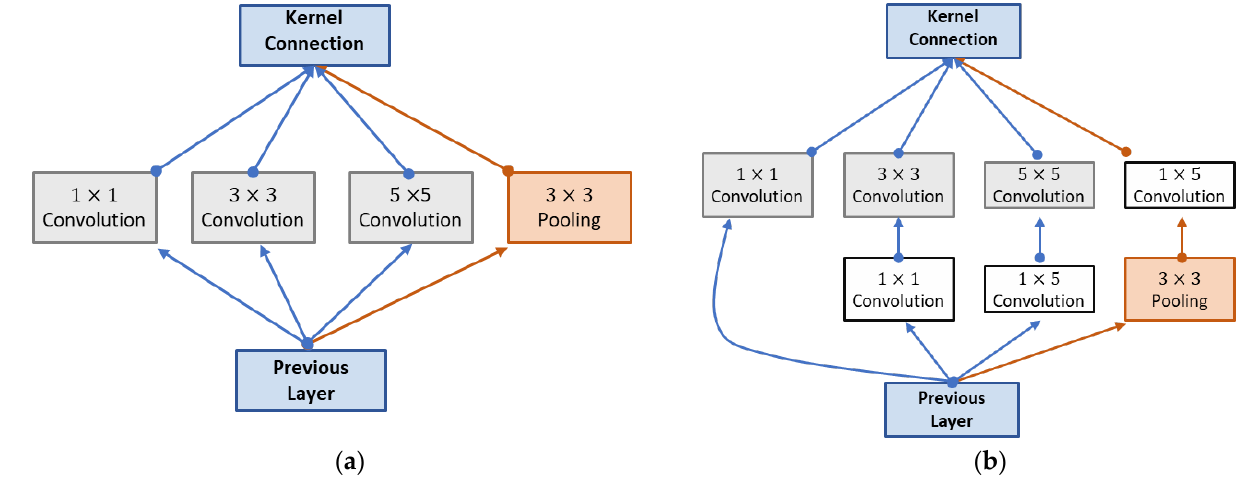
Figure 4. GoogleNet's inception module. ( a ) Inception module with no convolution layer. ( b ) A 1 × Figure 4. GoogleNet’s inception module. ( a ) Inception module with no convolution layer. 1 convolution layer in inception ”Reprinted with permission from Ref. [15]. 2022, Samee et al.” . ( b ) A 1 × 1 convolution layer in inception “Reprinted with permission from Ref. [15]. 2022, Samee et